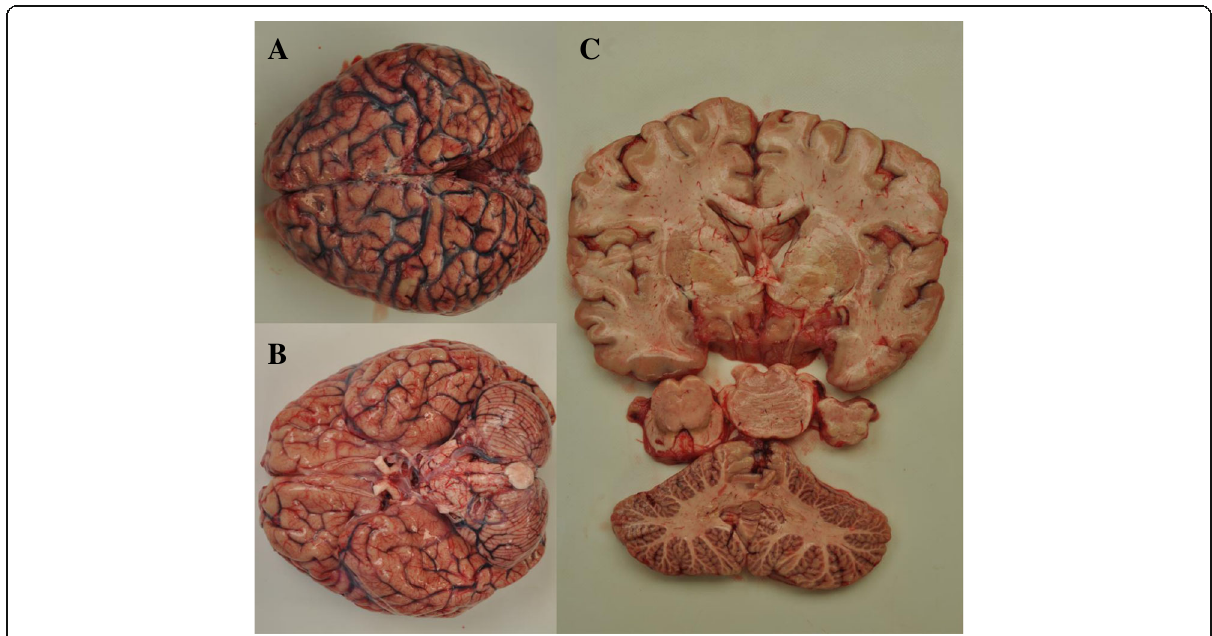
Fig. 3 Macroscopic images of the brain. The brain surface was unremarkable with no arteriosclerosis. The cut surface revealed no signs of cerebral hemorrhage or infarction. a Upper side view. b Basal side view. c Cut